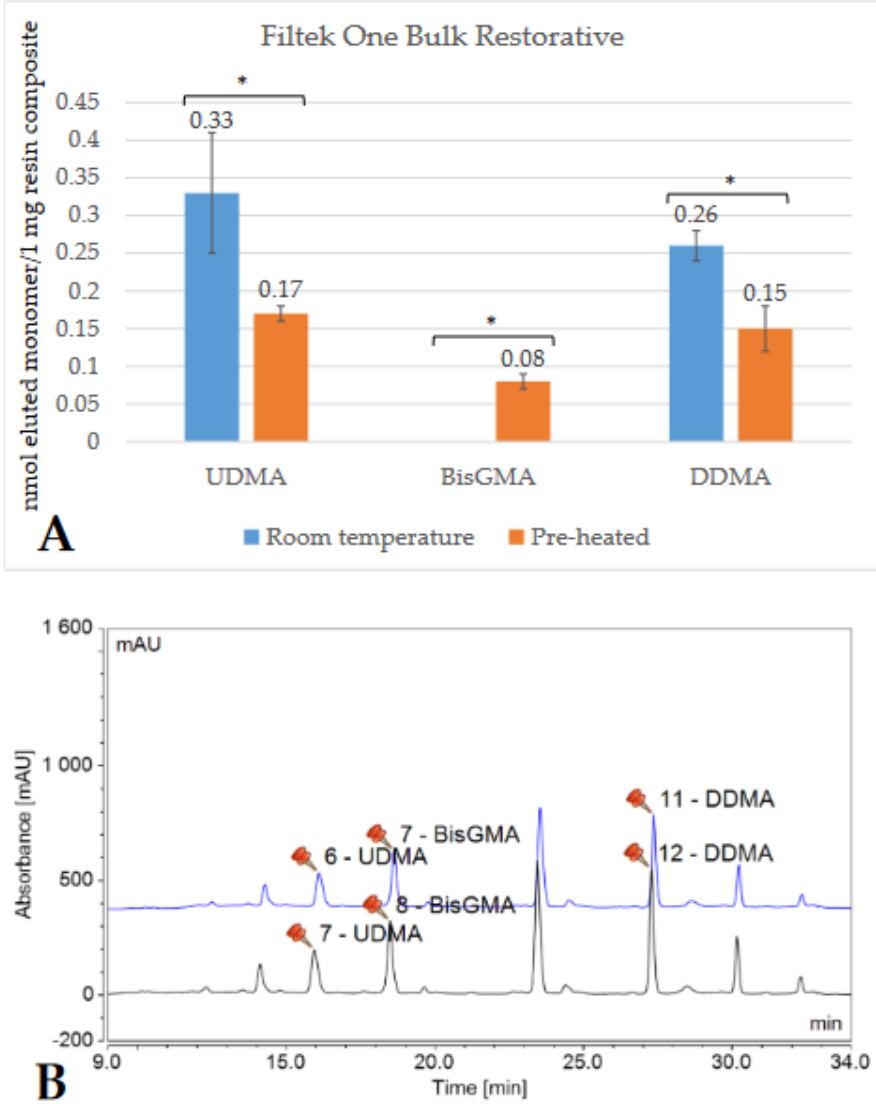
Figure 2. Comparison ( A ) of the amount of eluted monomers from room-temperature (blue bars) and pre-heated (orange bars) Filtek One Bulk Restorative samples. The * mark indicates statistically significant differences between the groups according to the independent two-tailed t -test. The chro- matogram ( B ) shows the detected monomers eluting from room-temperature (black chromatogram) and pre-heated (blue chromatogram) Filtek One Bulk Restorative (FOB) and their retention times based on the standard monomers, evaluated at a 205 nm wavelength. (Abbreviations: UDMA, urethane-dimethacrylate; BisGMA, bisphenol A-glycidyl methacrylate; DDMA, 1,12-dodecanediol- dimethacrylate; mAU, milli-Absorbance